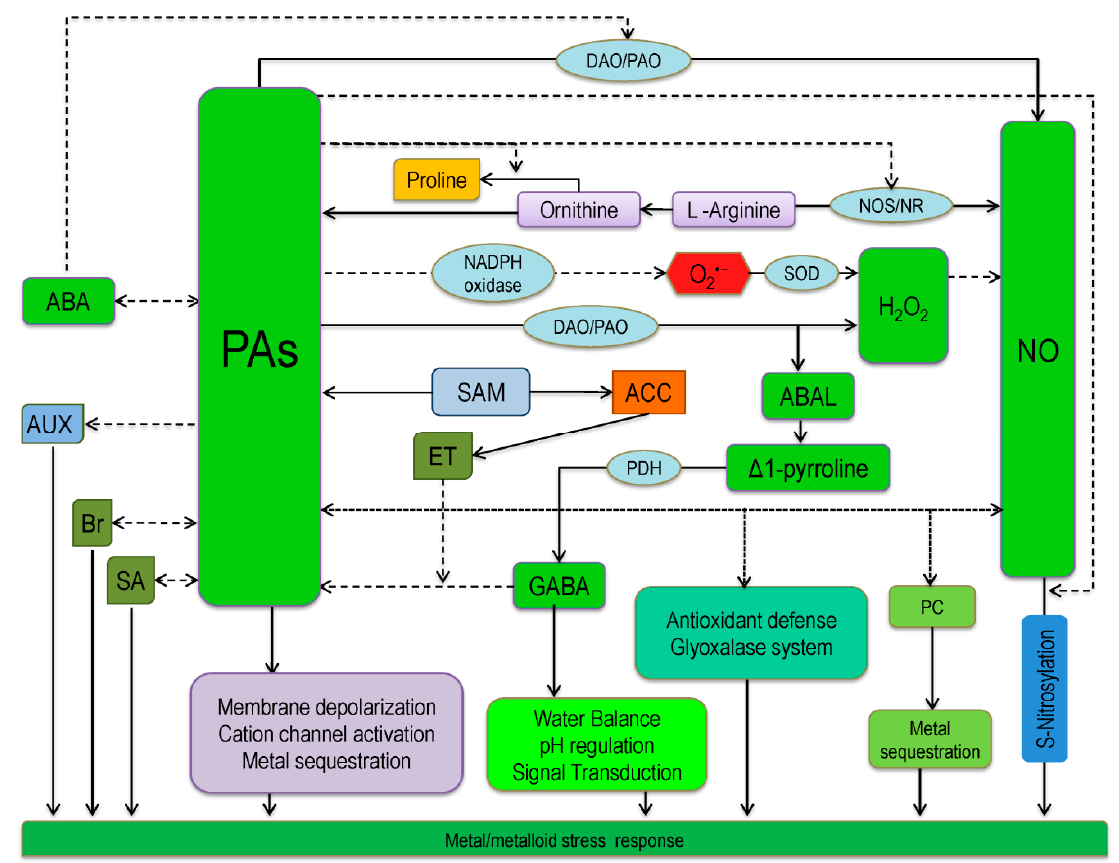
Figure 5. Interaction of polyamines with other molecules conferring metal/metalloid stress in plants. Dotted arrows represent stimulation/upregulation and solid arrows represent conversion/synthesis.